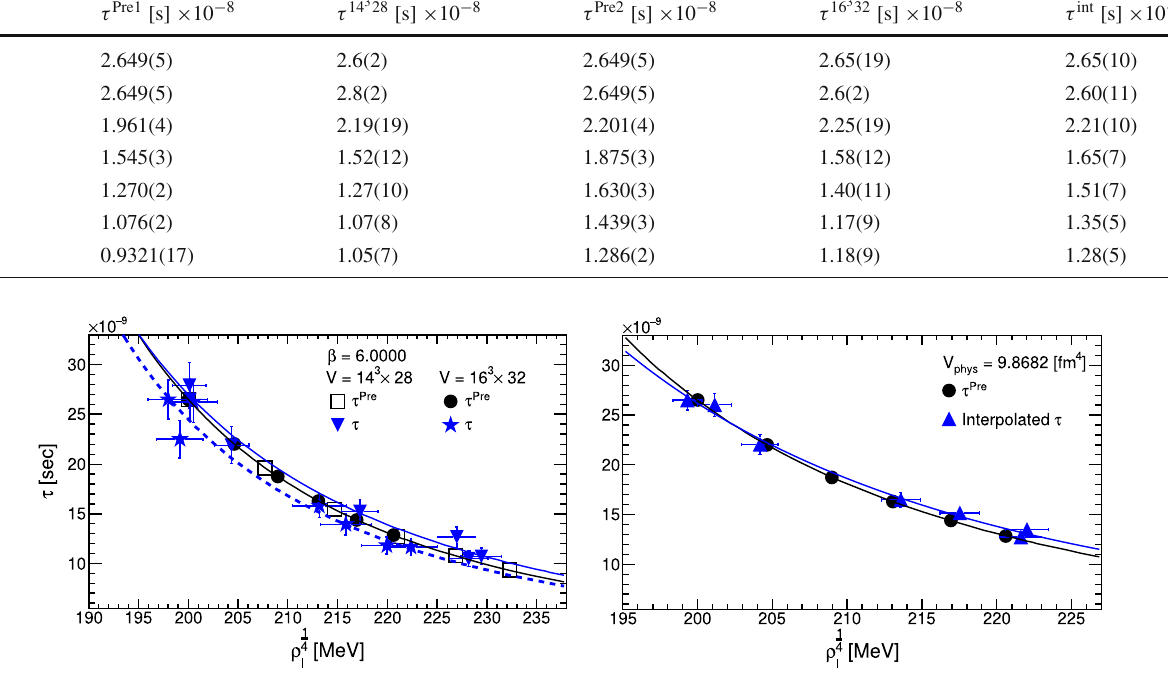
Fig. 21 Comparing the lifetime of the charged pion τ of the configu- rations of β = 6 . 0000, V = 14 3 × 28 and V = 16 3 × 32 (left) and the continuum limit (right) with the prediction τ Pre . In the left figure, the black full line, the blue full line, and the blue dashed line indicate the